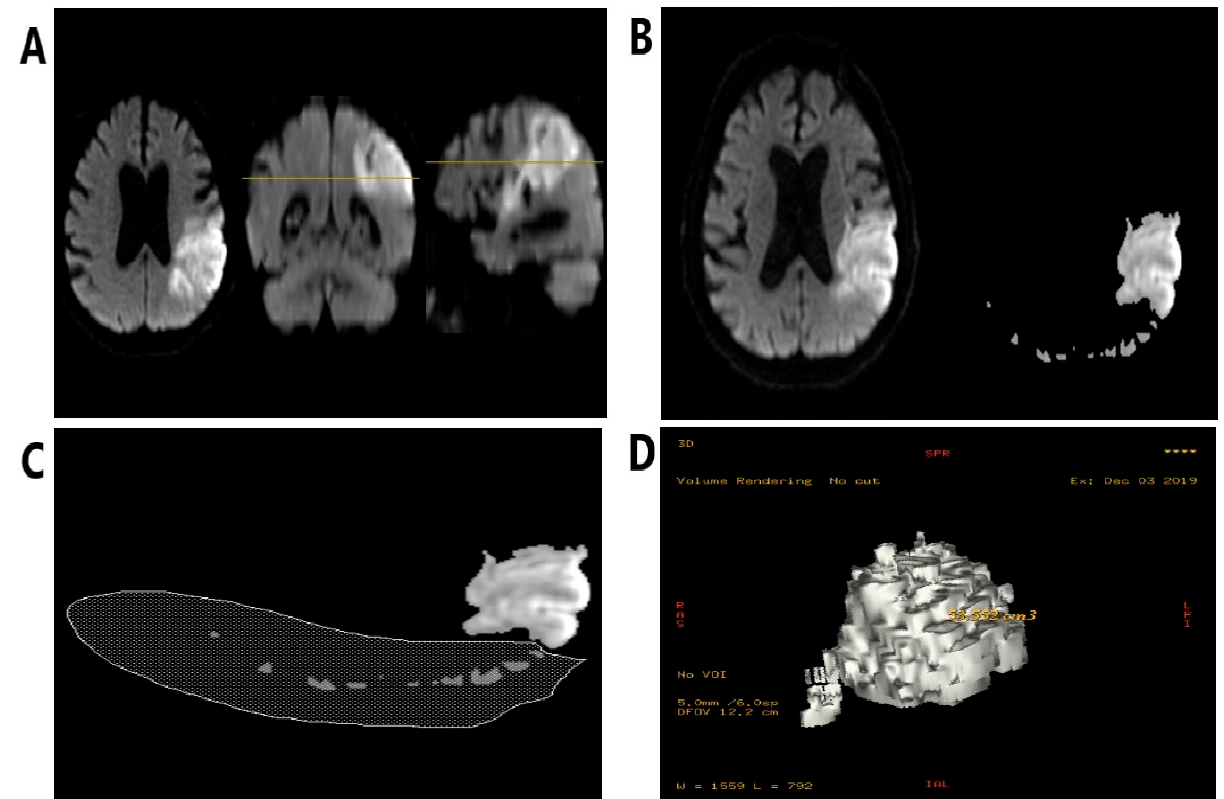
Figure 2. The steps for determining the volume of acute ischemic infarct . ( A ) Primary magnetic resonance (MR) image from a diffusion-weighted imaging (DWI) sequence; native axial view, and additional coronal and sagittal reconstructions. ( B ) On the left side, the original axial MR image from the DWI sequence. On the right side, the effect of limiting the displayed voxels to a chosen signal intensity range. ( C ) Manual removal of residual voxels (noise) outside of the ischemic stroke area. ( D ) Volumetric reformation of stroke with its volume displayed.